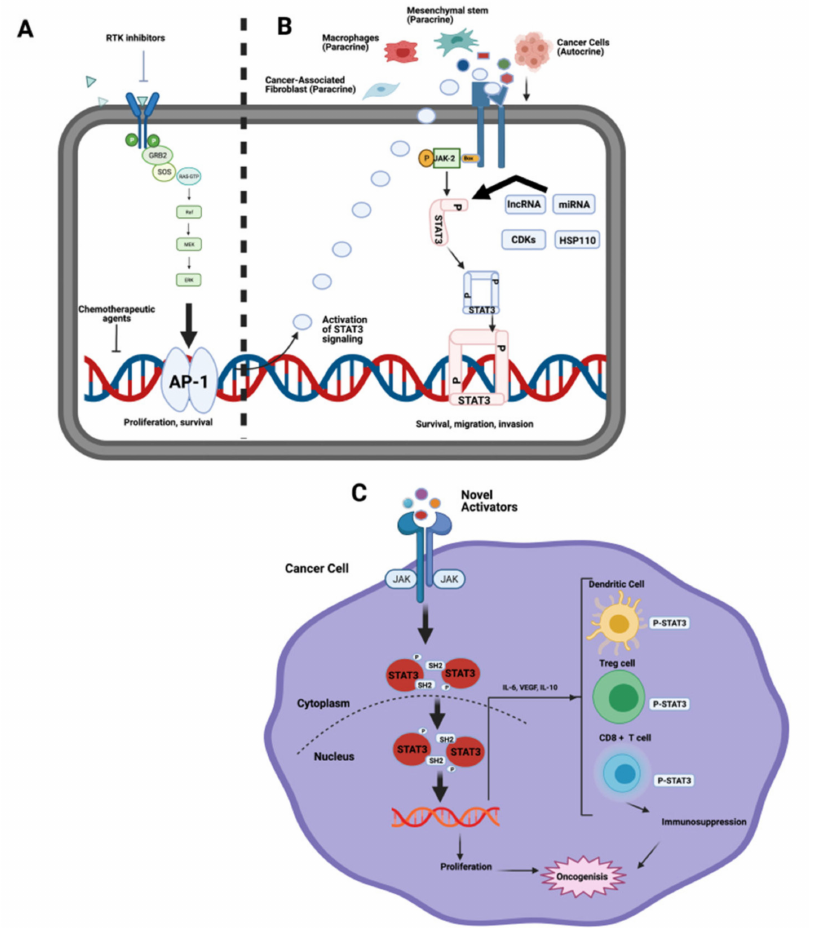
Figure 7. Activation of STAT3 in cancer cells. ( A ) Inhibition of cancer signaling activates STAT3 pathways. ( B ) Novel activators of STAT3 secreted by cancer cells, mesenchymal stem cells, cancer- associated fibroblast cells, or macrophages. ( C ) Activators of STAT3 promote cancer growth through immunosuppression. STAT3 target genes IL-6, IL-10, and VEGF are regulated by STAT3. These tumor-associated factors activate STAT3 in the immune system (Modified from